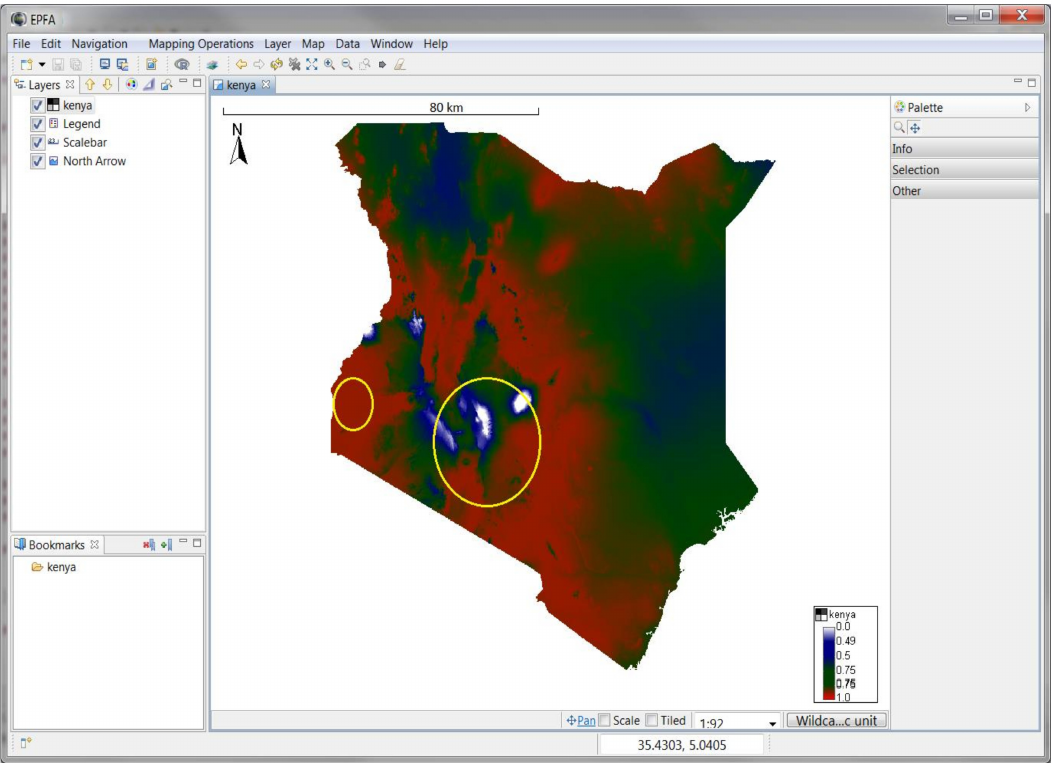
Figure 8. Kenyan map of the potential e ffi cacy of ICIPE 62 isolate when used against mustard aphid, modeled with the software. The level of e ffi cacy varies between 0 and 1. Locations with 0% level of e ffi cacy are displayed in white, values between 0 and 0.5 are displayed in blue, values between 0.5 and 0.75 are displayed in green, and values between 0.75 and 1 are displayed in red. Red indicates the highest e ffi cacy levels. The yellow circles surround areas in Kenya where the EPF isolate ICIPE 62 is successfully used, and results were used for validation of the developed